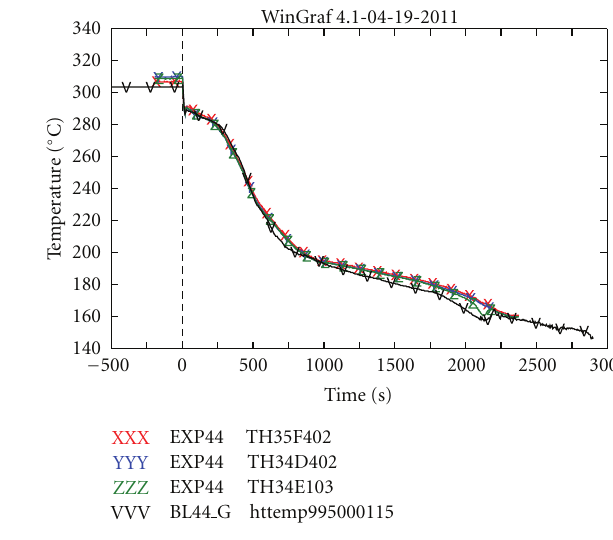
Figure 16: Cladding temperature at bottom level.